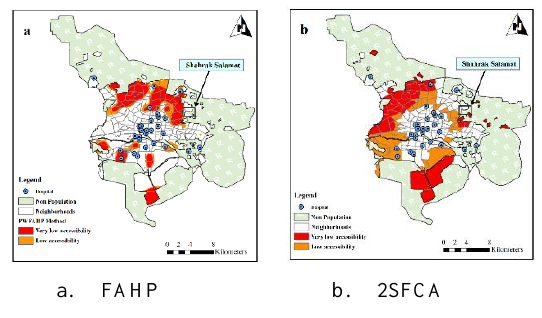
Figure 7. High priorities areas for health and urban